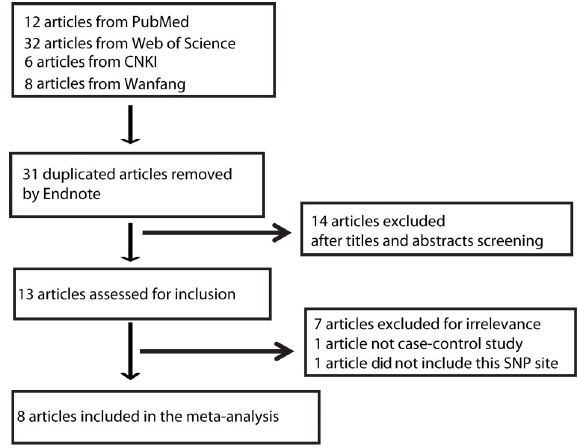
Figure 1. Flow diagram of inclusion of studies in the meta-